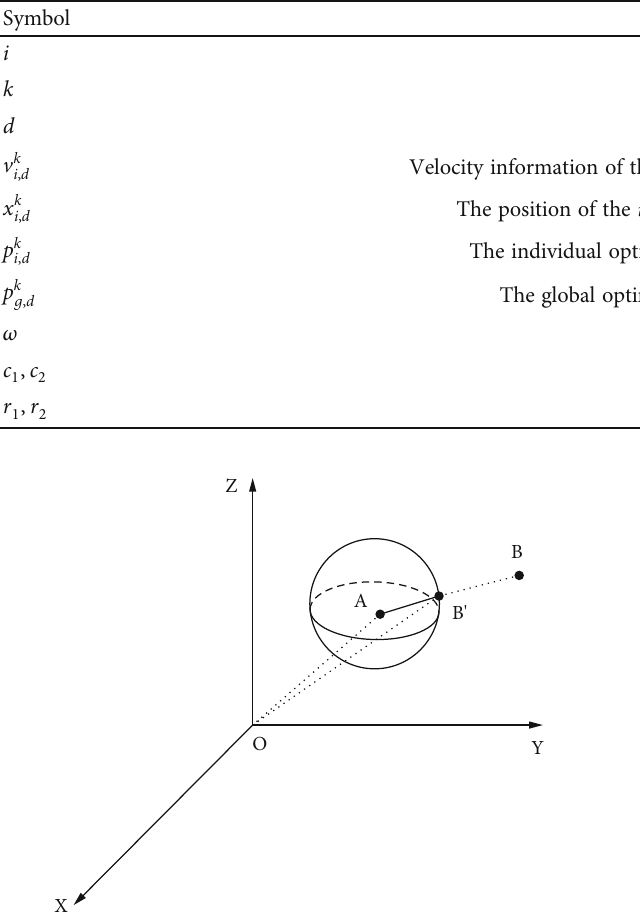
Figure 5: Diagram of modifying particles that are beyond the search range.